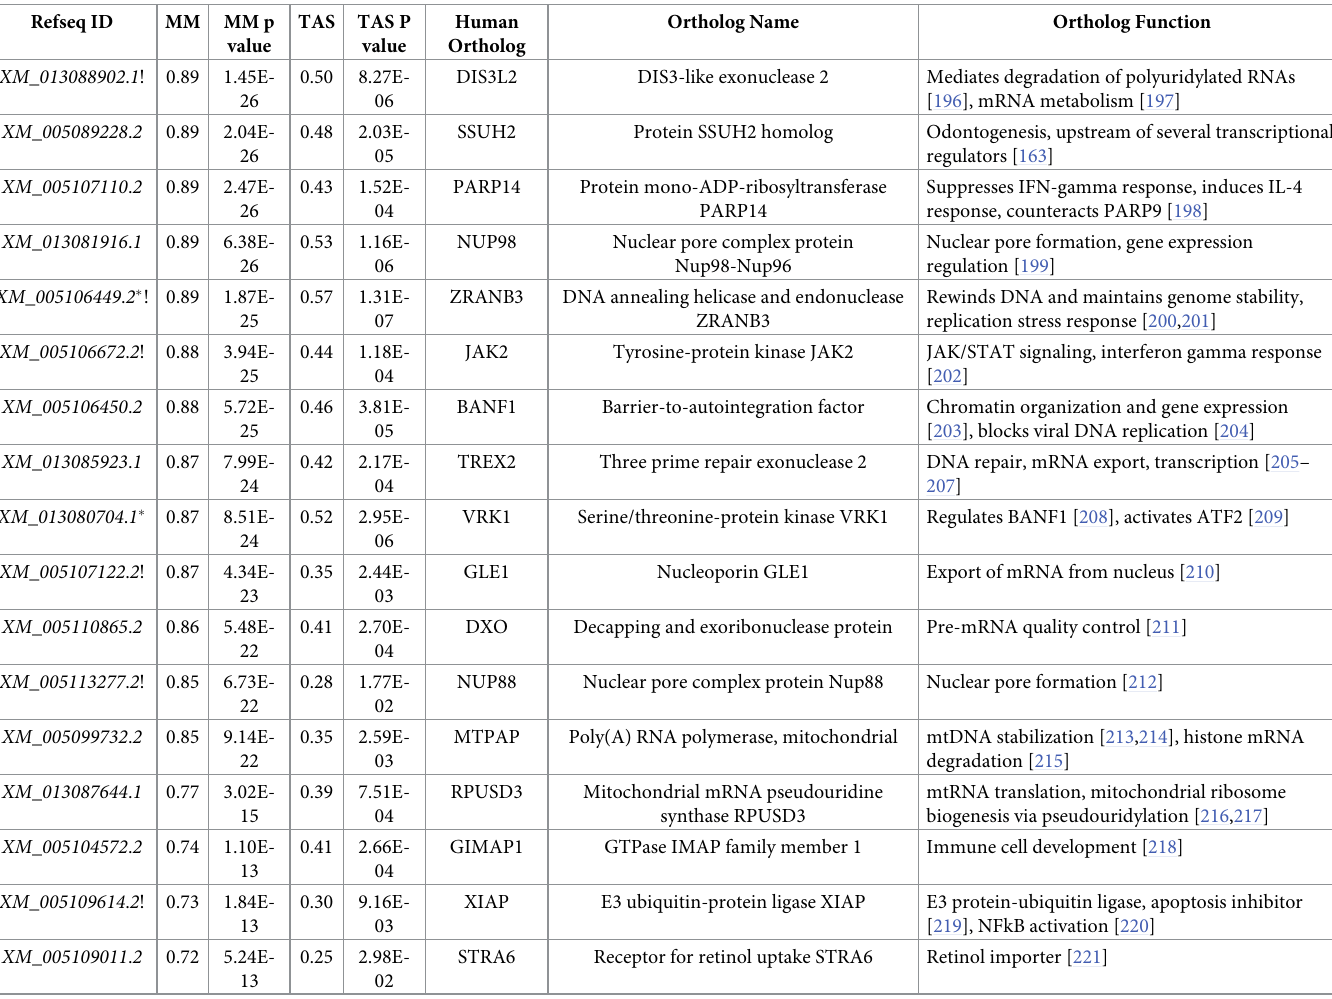
See Table 2 for description of organization. Common functions include nuclear pore formation, DNA damage repair, immune and inflammation signaling. The expression trend of this module increased linearly until age 10 months after which it stabilized, suggesting increasing activity of these in early age and stable, heightened activity in old